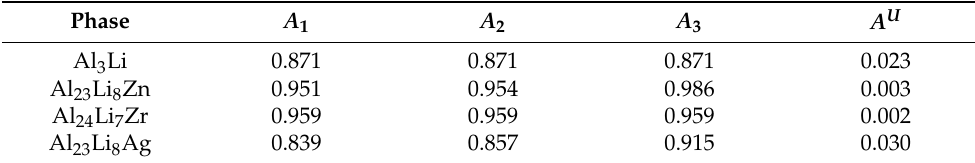
Table 3. Predicted universal anisotropy index ( A U ) and shear anisotropic factors ( A 1 , A 2 and A 3 ) of pure and doped Al 3